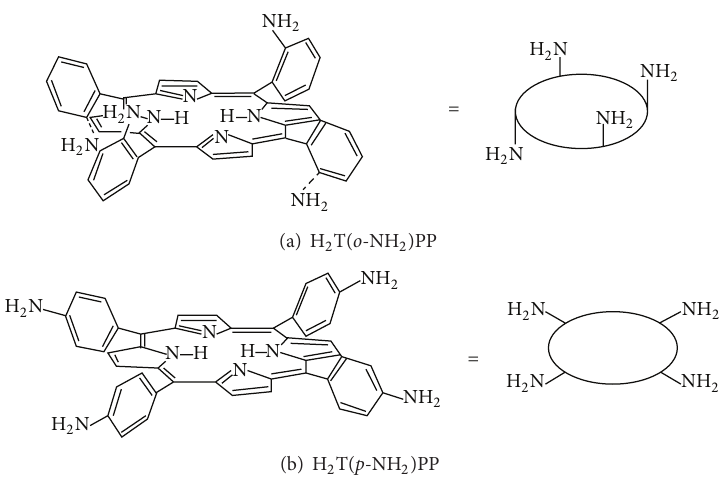
Figure 2: Structural representation of: (a) ortho -amino, H 2 T( o -NH 2 )PP, and (b) para -amino, H 2 T( p -NH 2 )PP, isomers of substituted